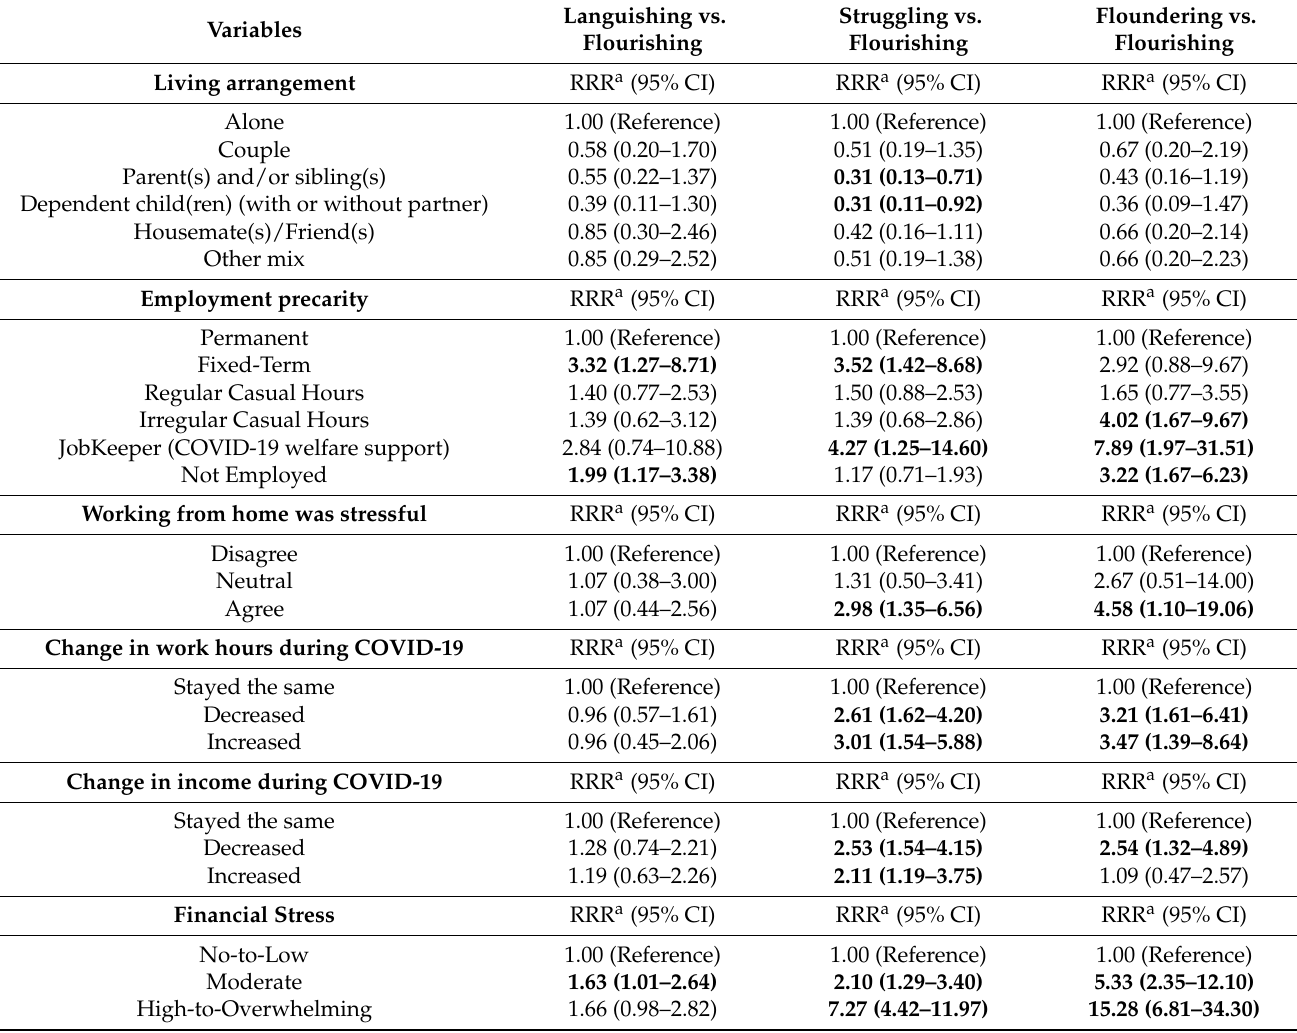
Table 3. Associations between living arrangement, employment, and financial variables with mental health state during the COVID-19 pandemic. Variables